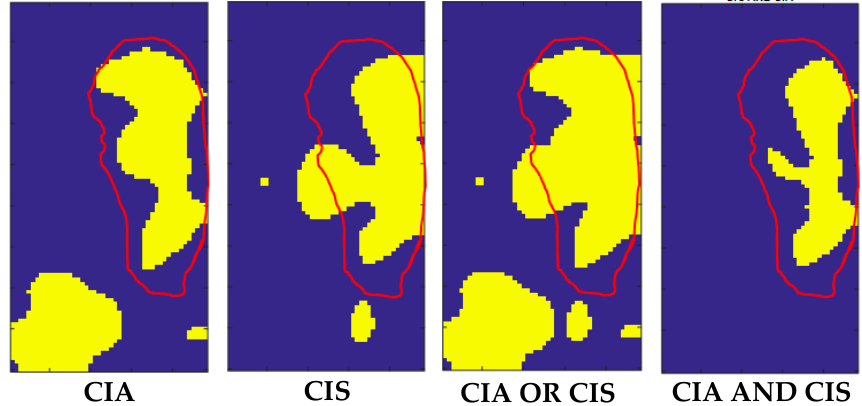
CIA CIS CIA OR CIS CIA AND CIS Figure 11. From left to right: CIA, CIS, OR-logic and AND-logic maps for liver sample #2. The scanned area was 16 × 30 mm 2 . The total number of the scanned points was n = 120.